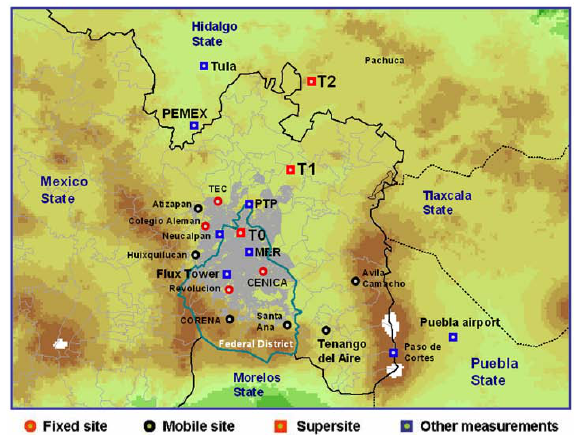
Fig. 4. MCMA-2006: Ground-Based Measurement Sites.